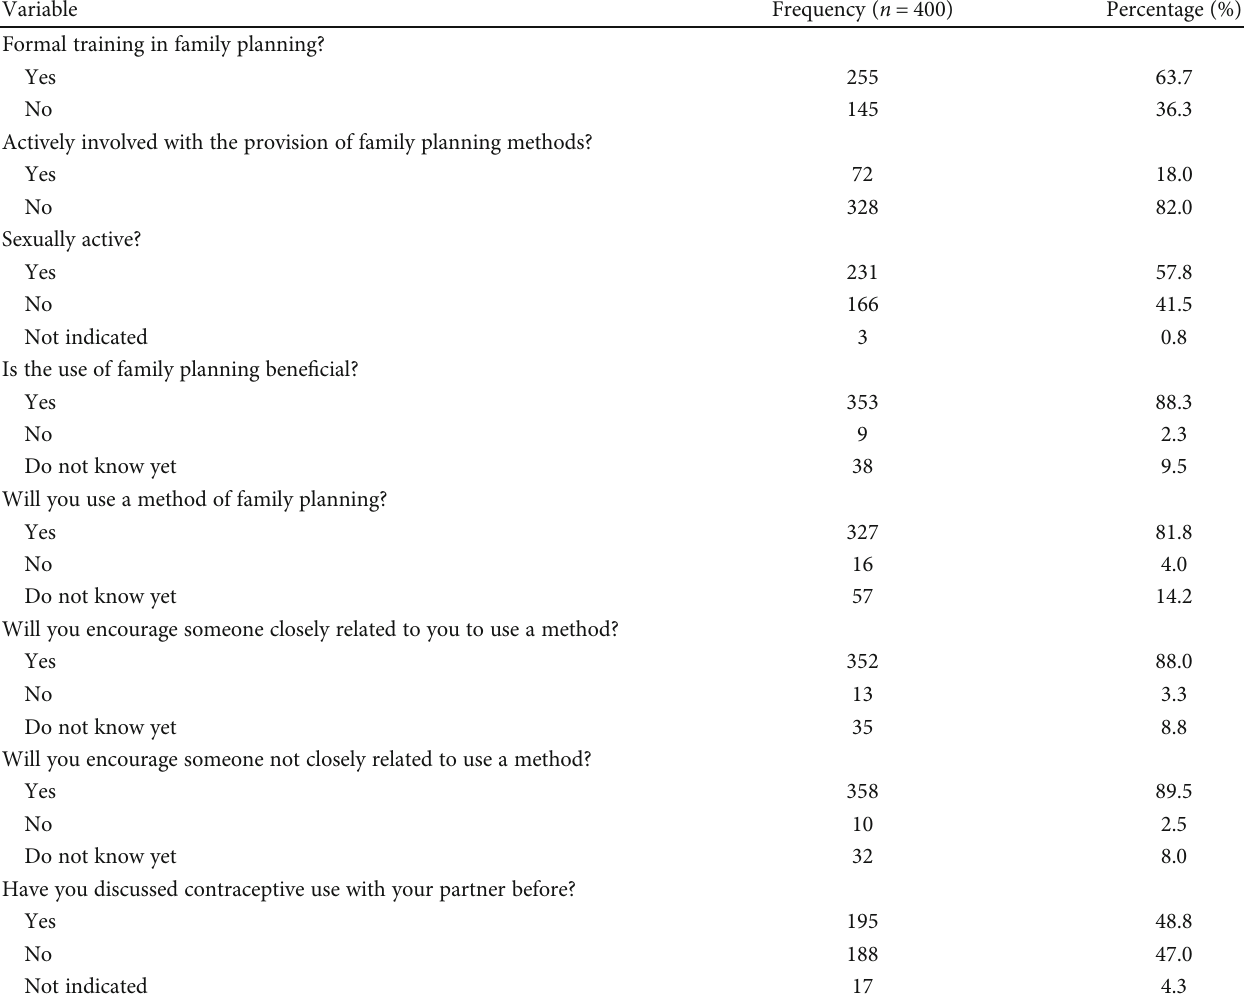
Table 2: Healthcare givers ’ attitudes towards family